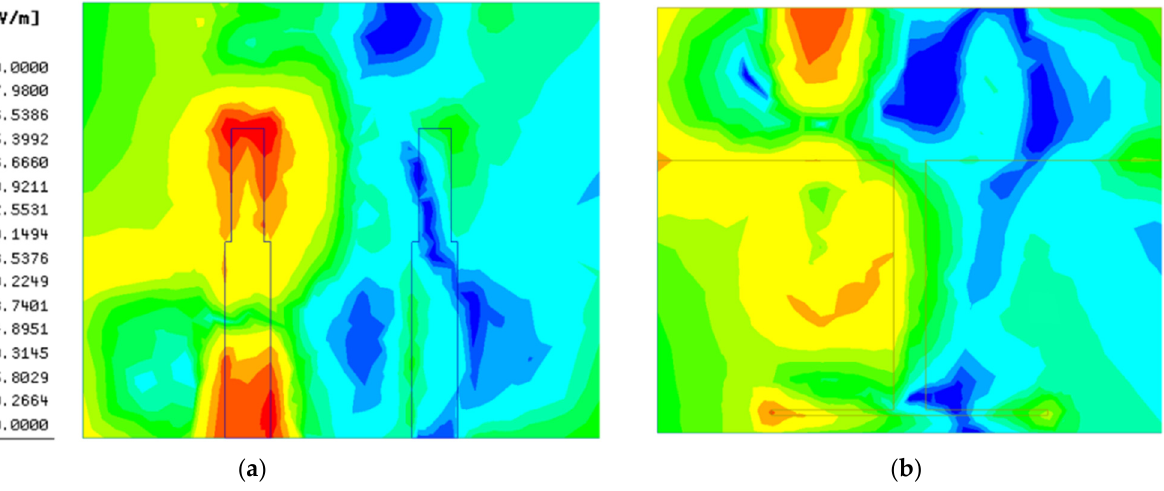
Figure 9. The distribution of surface electric field of antenna 3: ( a ) top surface; ( b ) bottom surface.